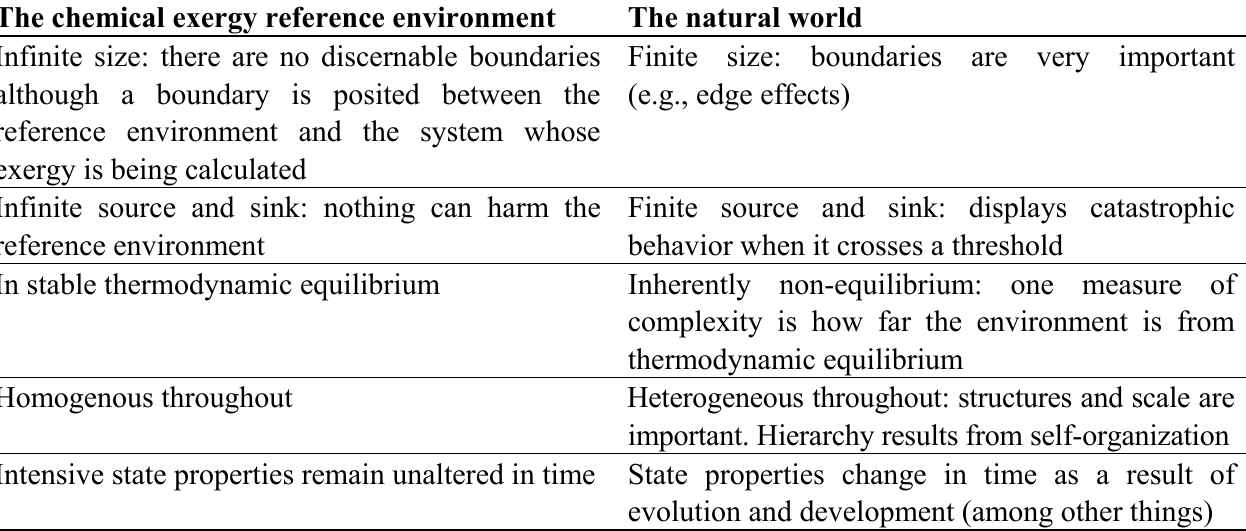
Table 2. A basic contrast between the chemical exergy reference environment and the natural